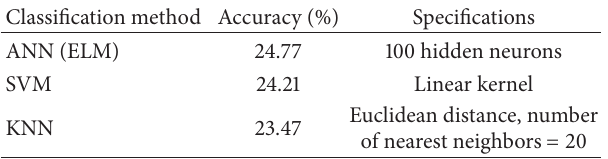
Table 2: A comparative result of vowel independent age estimation.